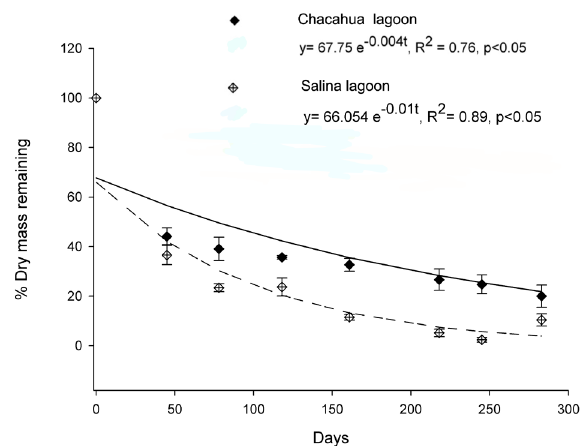
Figure 2. Leaf degradation rate in the Chacahua and Salina lagoons, Mexico (± SE = standard error).